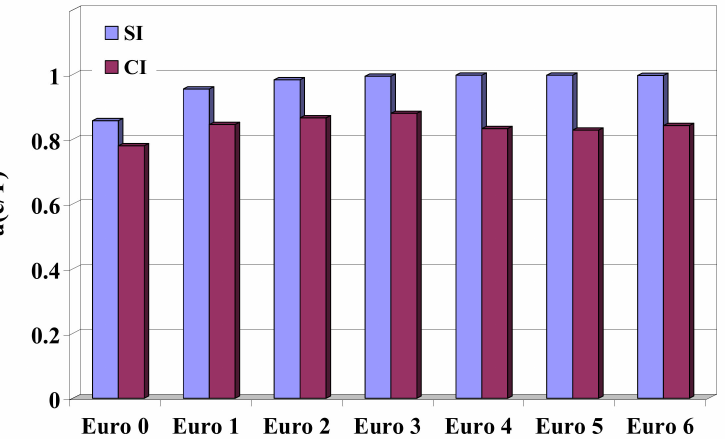
Figure 18. Share of additional non-methane volatile organic compounds emission in total emission— u(c/T), from passenger cars of pollutant emission categories Euro 0–Euro 6, during warm-up of spark- ignition engines—SI and compression-ignition engines—CI, under model vehicle traffic